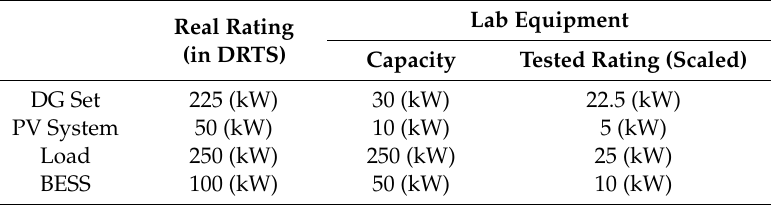
Figure 5. Power-hardware-in-the-loop (PHIL) testing setup for the microgrid controller in the test lab. The limitation of lab equipment is removed by integrating test lab with DRTS as PHIL environment. Table 1. Microgrid components.